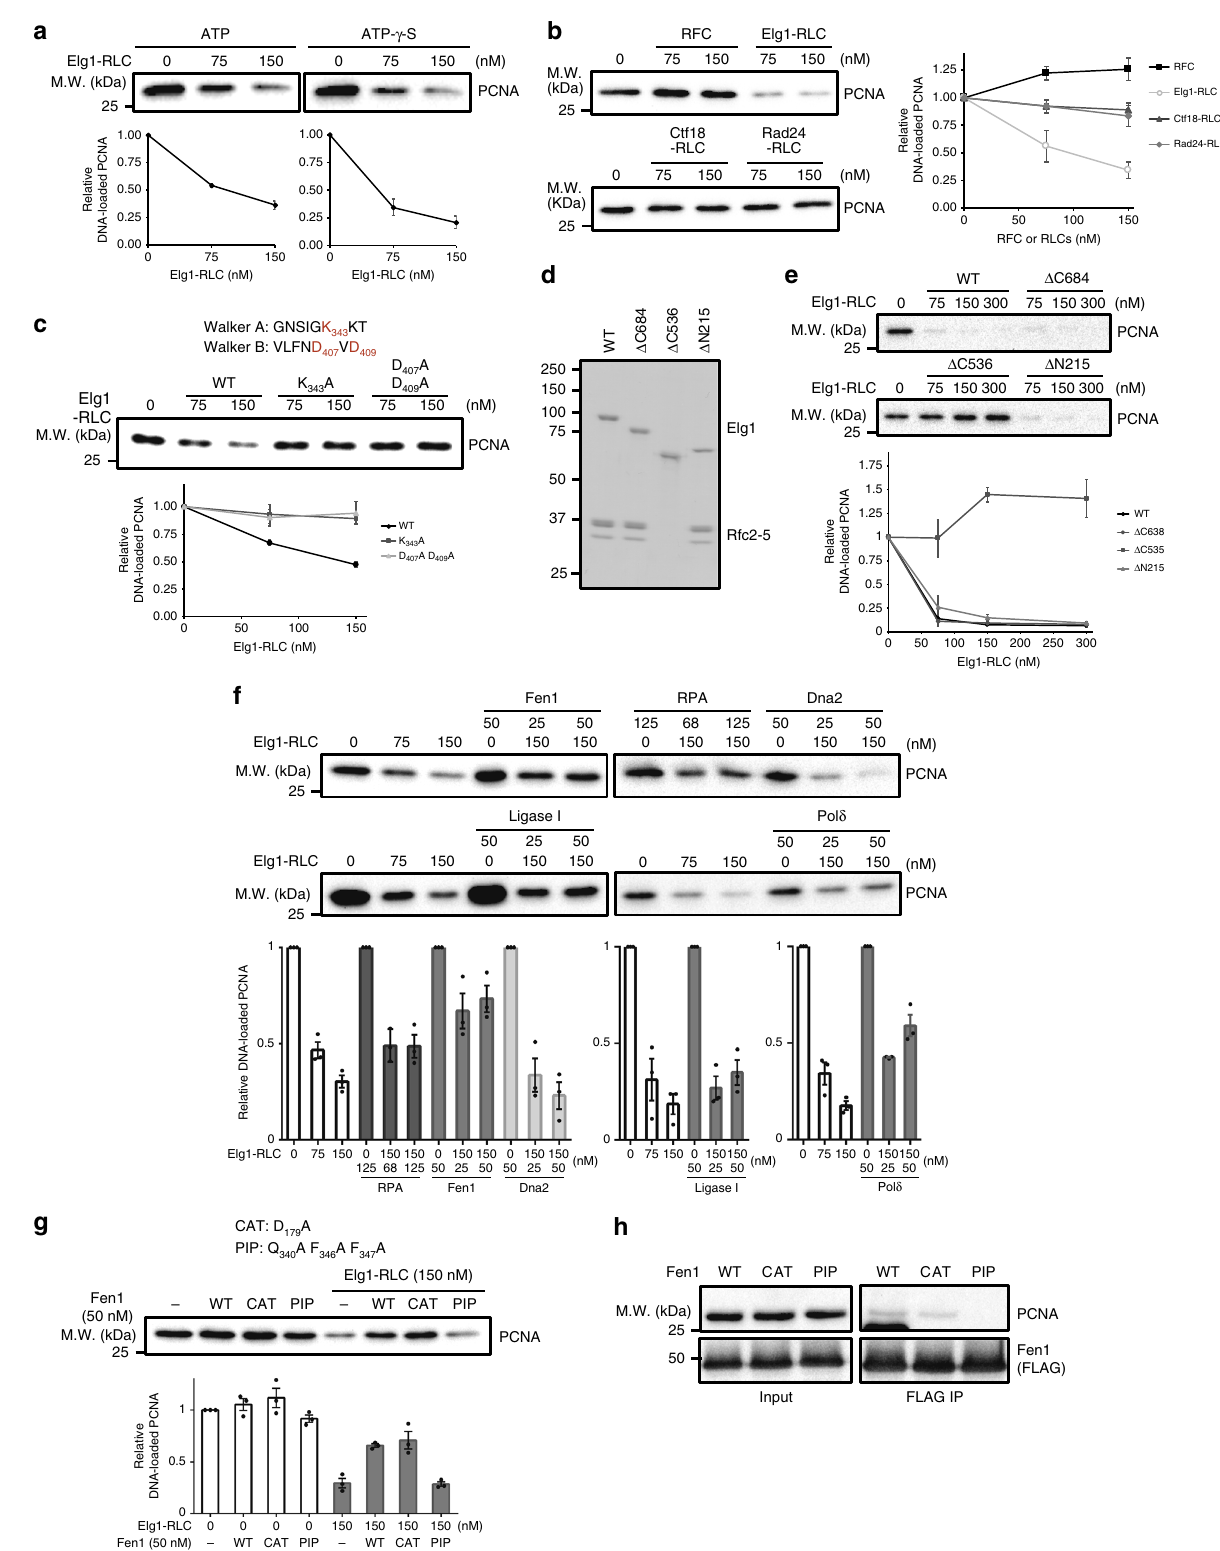
Supplementary Fig. 6f). Next, we examined PCNA unloading activity of Egl1 deletion mutants (Fig. 6d). Deletion of N-terminal 215 amino acids of Elg1 did not affect PCNA unloading activity of Elg1-RLC (Fig. 6e). Therefore, although Elg1-RLC is